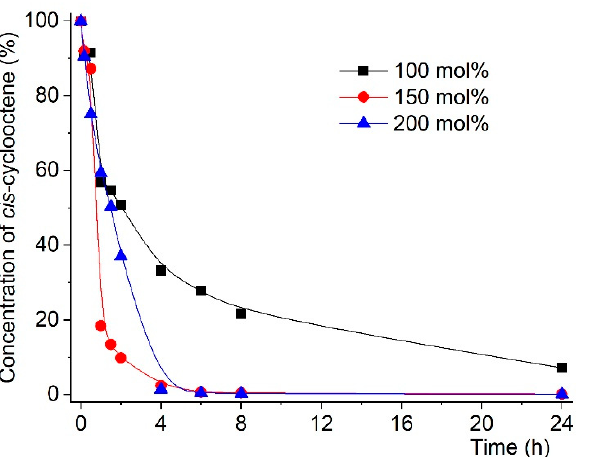
Figure 9. Kinetics of cis -cyclooctene epoxidation in the presence of MNP 11 -Si-phos-Mo catalyst in toluene at 383 K, and with different tert -butylhydroperoxide (tbhp): substrate ratios.